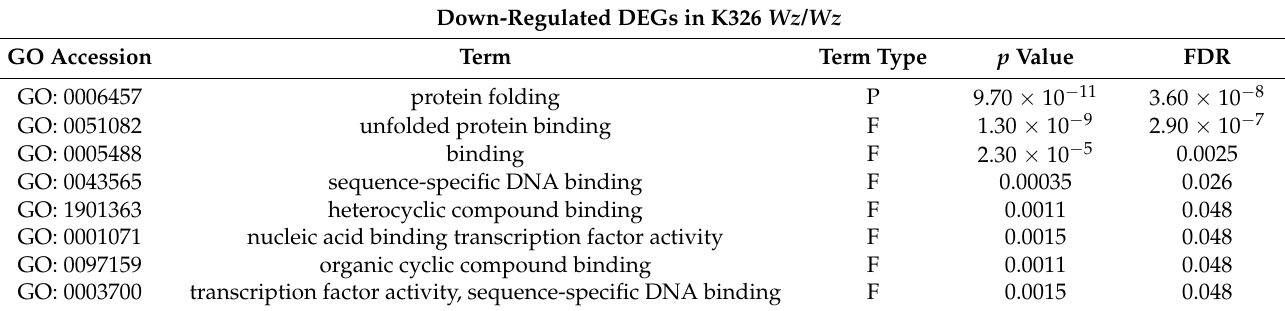
Table 9. GO terms enriched for DEGs exclusively identified in K326 Wz/Wz inoculated with the Wz -H isolate. Down-Regulated DEGs in K326